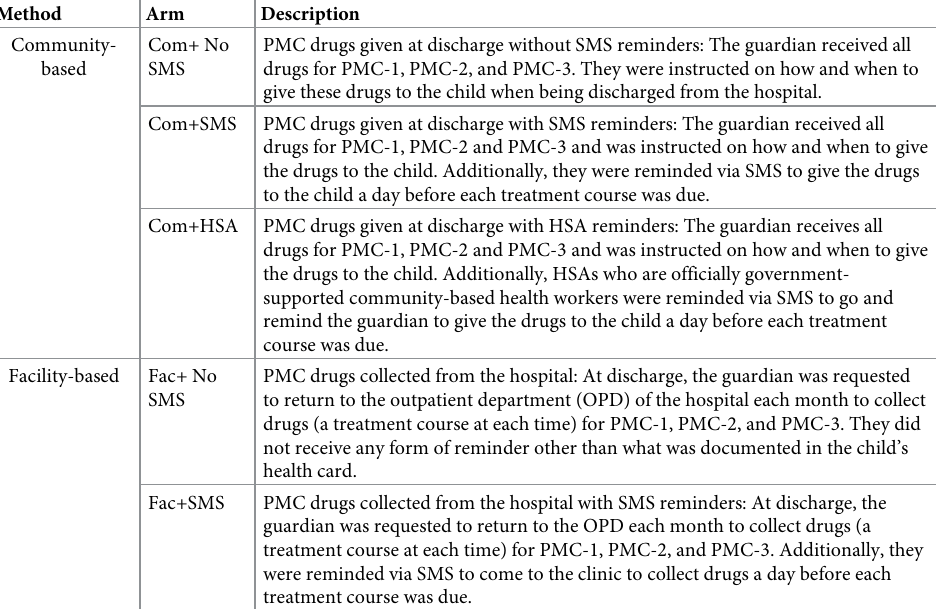
Table 1. Detailed description of delivery methods of